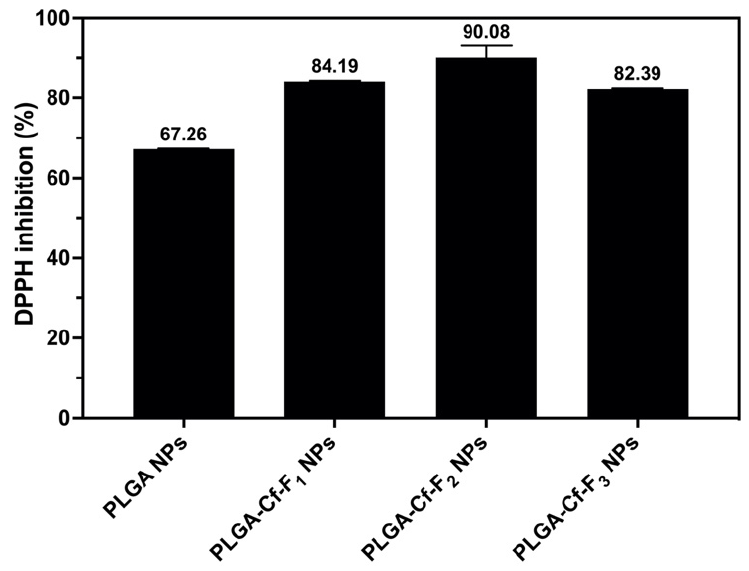
Figure 7. Antioxidant activity of PLGA NPs and different PLGA-Cf NPs expressed in (DPPH inhi- bition%).